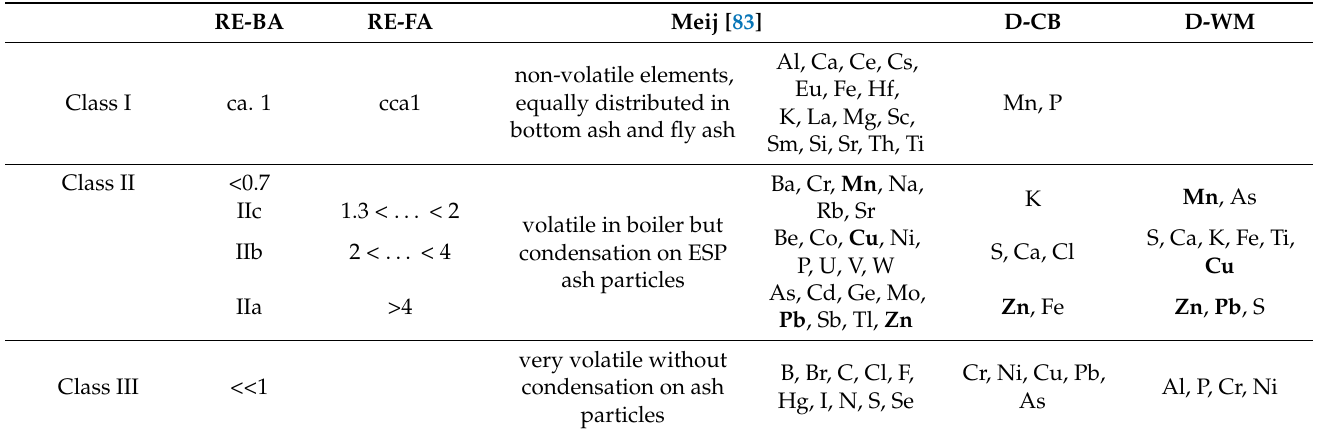
Table 10. Comparison of elements characterised by the RE value according to the classification of Meij [83]. Figure 7. The grain size analysis of combustion products from coal briquettes.